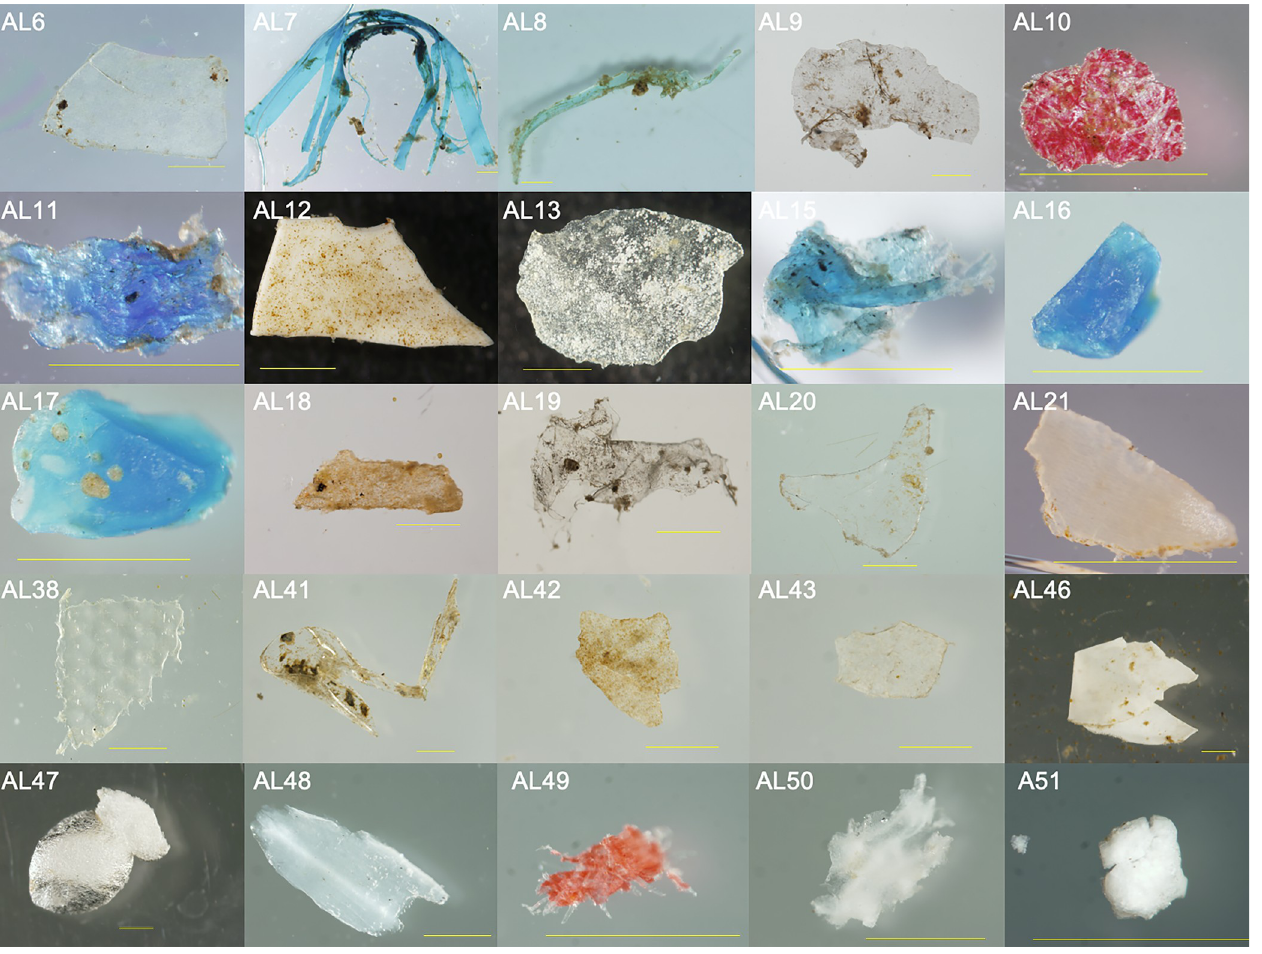
Fig 1. Representative putative microplastics from environmental samples photographed with a stereo-zoom microscope/camera after their collection from surface waters of the Elizabeth River at Old Dominion University’s Sailing Center. Samples were collected from June through November 2015. Most pieces were distinctly biofouled. Bars represent one